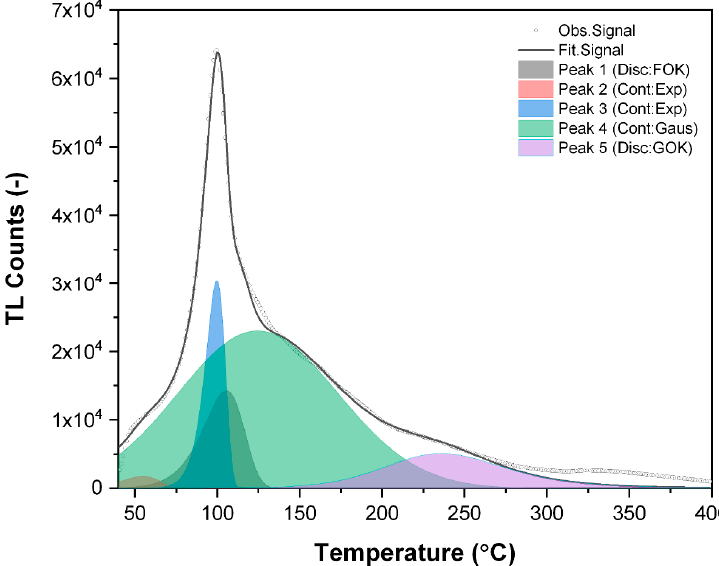
Figure 10. Results of deconvolution procedure of TL signal from PPG samples irradiated with 10